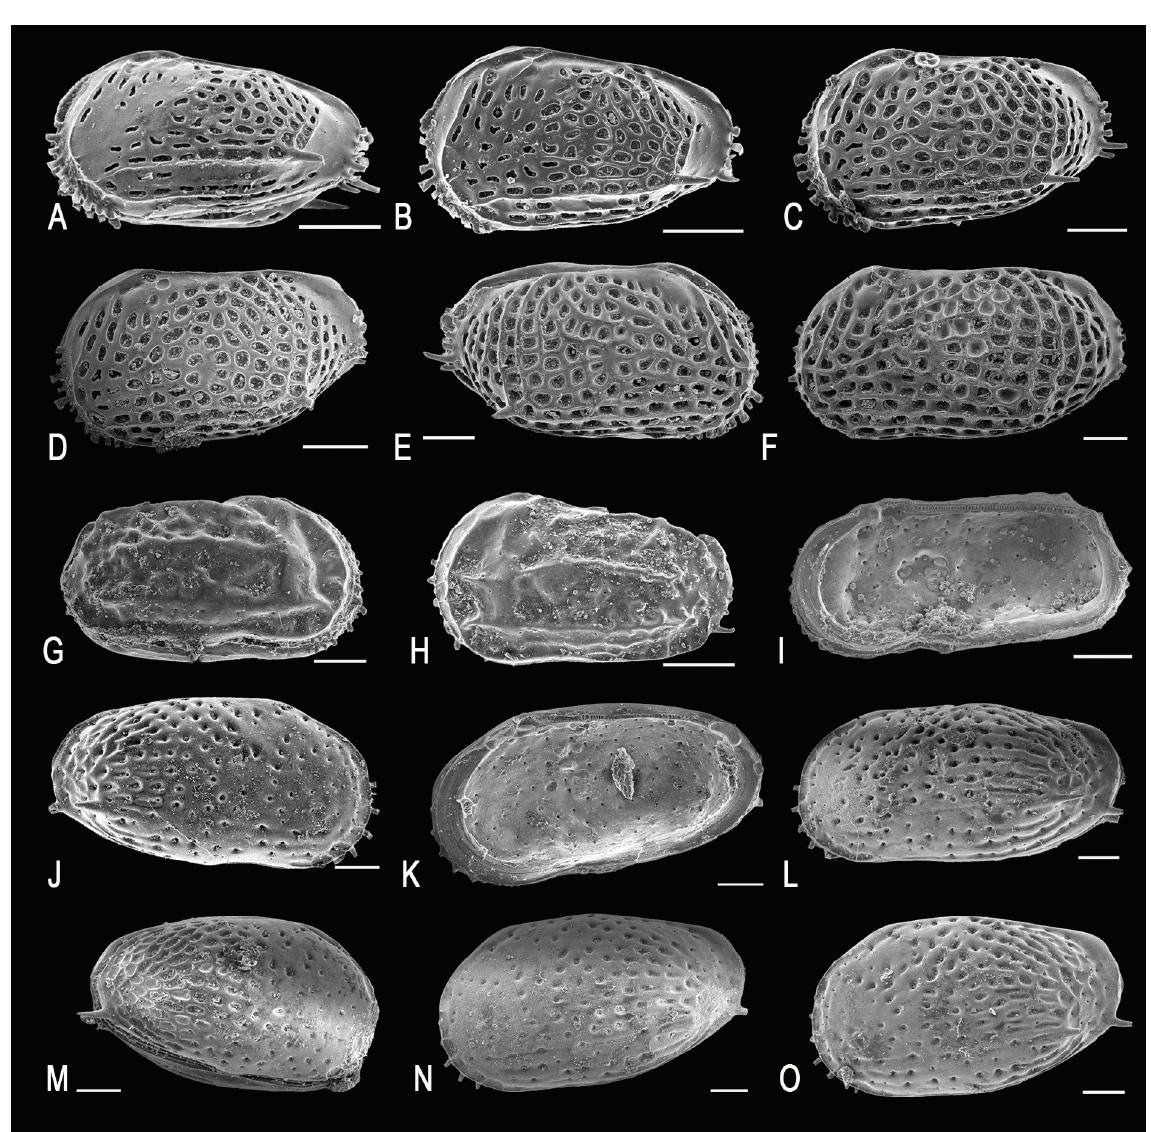
Fig. 7. Holocene ostracods from Samut Sakhon Province, Central Thailand. A–E . Keijella gonia Zhao & Whatley, 1989. A . Carapace, left lateral view, SUT-20SS-C310. B . Carapace, left lateral view, SUT-20SS-C311. C . Carapace, left lateral view, SUT-20SS-C312. D . Carapace, right lateral view, SUT- 20SS-C288. E . Carapace, right lateral view, SUT-20SS-C286. – F . Pistocythereis sp. Carapace, right lateral view, SUT-20SS-C305. – G–I . Stigmatocythere bona Chen in Hou, Chen, Yang, Ho, Zhou & Tian, 1982. G . Carapace, right lateral view, SUT-20SS-C201. H . Carapace, left lateral view, SUT-20SS-C200. I . Valve, internal view of right valve, SUT-20SS-C190. – J–O . Keijella multisulcus Whatley & Zhao, 1988 . J . Valve, juvenile, right lateral view, SUT-20SS-C231. K . Valve, juvenile, internal view of right valve, SUT-20SS-C213. L . Carapace, male, left lateral view, SUT-20SS-C225. M . Carapace, female, left lateral view, SUT-20SS-C242. N . Carapace, female, left lateral view, SUT-20SS-C206. O . Carapace, female, left lateral view, SUT-20SS-C243. Scale bars = 0.1.